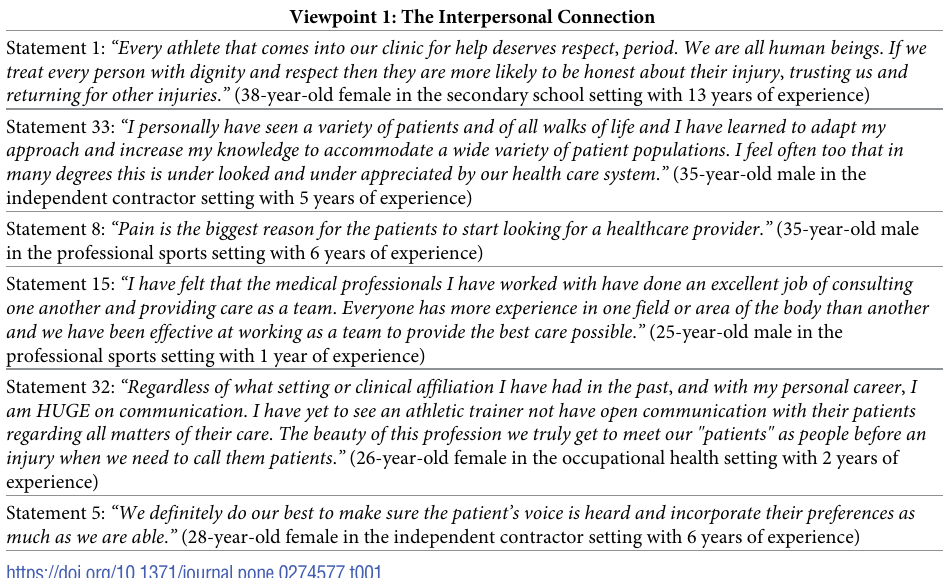
Table 1. Viewpoint 1 open-ended statements. Viewpoint 1: The Interpersonal